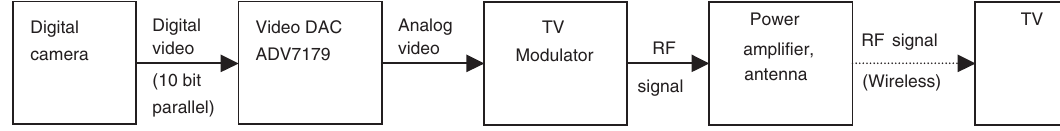
Figure 6 Block diagram of solution 2: digital camera + analog video transmission. Table 3 Comparison of analog and digital transmitters a Video transmission Analog Digital Property of video transmission Large bandwidth (6 MHz) High data rate (3 Mbps of CIF RF for uncompressed video transmission > 30 MHz > 2.4 GHz Circuit complexity Very simple